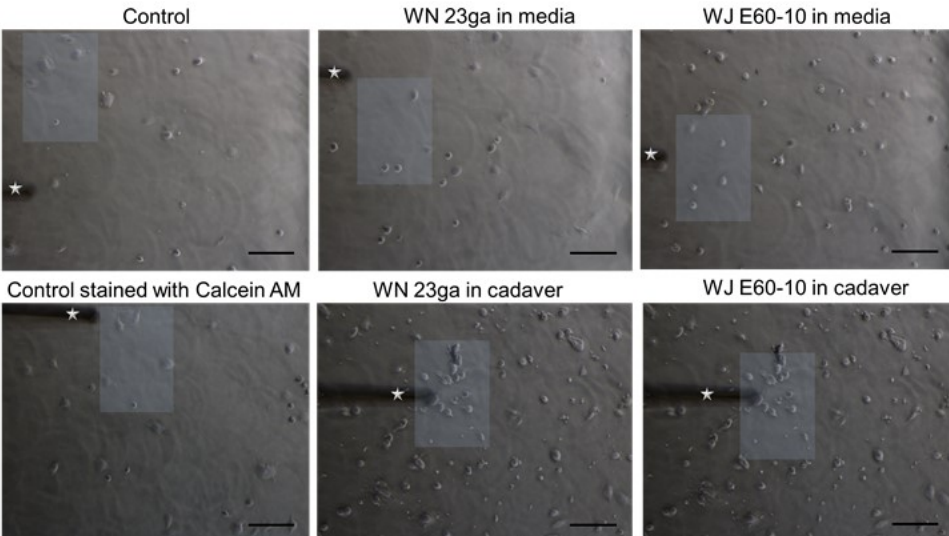
Figure 9. Representative images indicating the regions of interest subjected to elasticity measurements via AFM. Microscopic pictures of AFM-measured porcine adipose tissue-derived stromal cells (pADSCs) control monolayers (left pictures) and pADSCs injected by WN (middle pictures) or WJ (right pictures). Following WN and WJ injection, cells were collected, washed by PBS, and allowed to attach for 3 h in expansion medium before AFM measurements. As controls, cells that were not subjected to an injection procedure were used. The cantilever employed for measurements is also displayed (white star). Representative regions containing cells subjected to AFM measurements are also displayed (white squares). Images were acquired with the inverted AxioObserver D1 light microscope attached to the AFM system at a 10× magnification. Scale bar (black) represents 100 µm. Abbreviations: WJ—waterjet, WN—Williams needle.